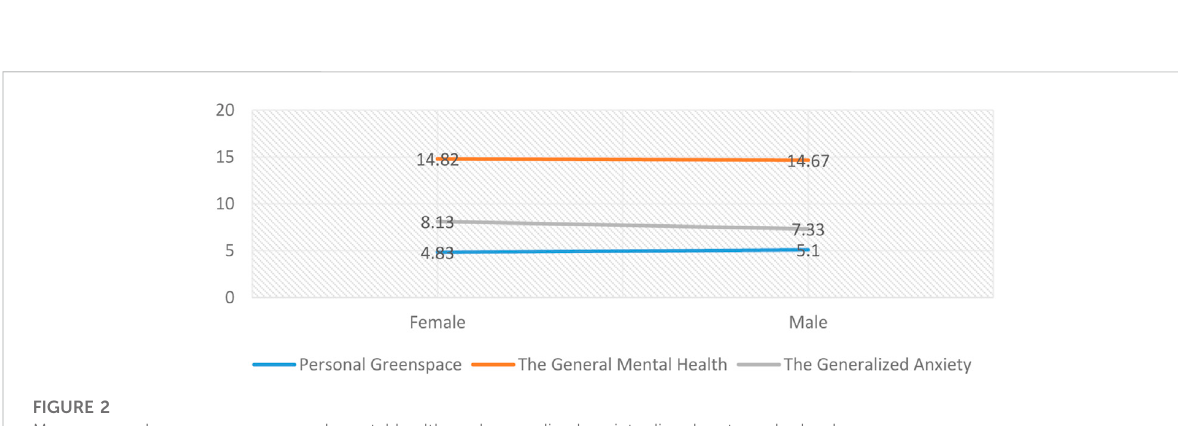
FIGURE 2 Mean personal green spaces, general mental health, and generalized anxiety disorder at gender